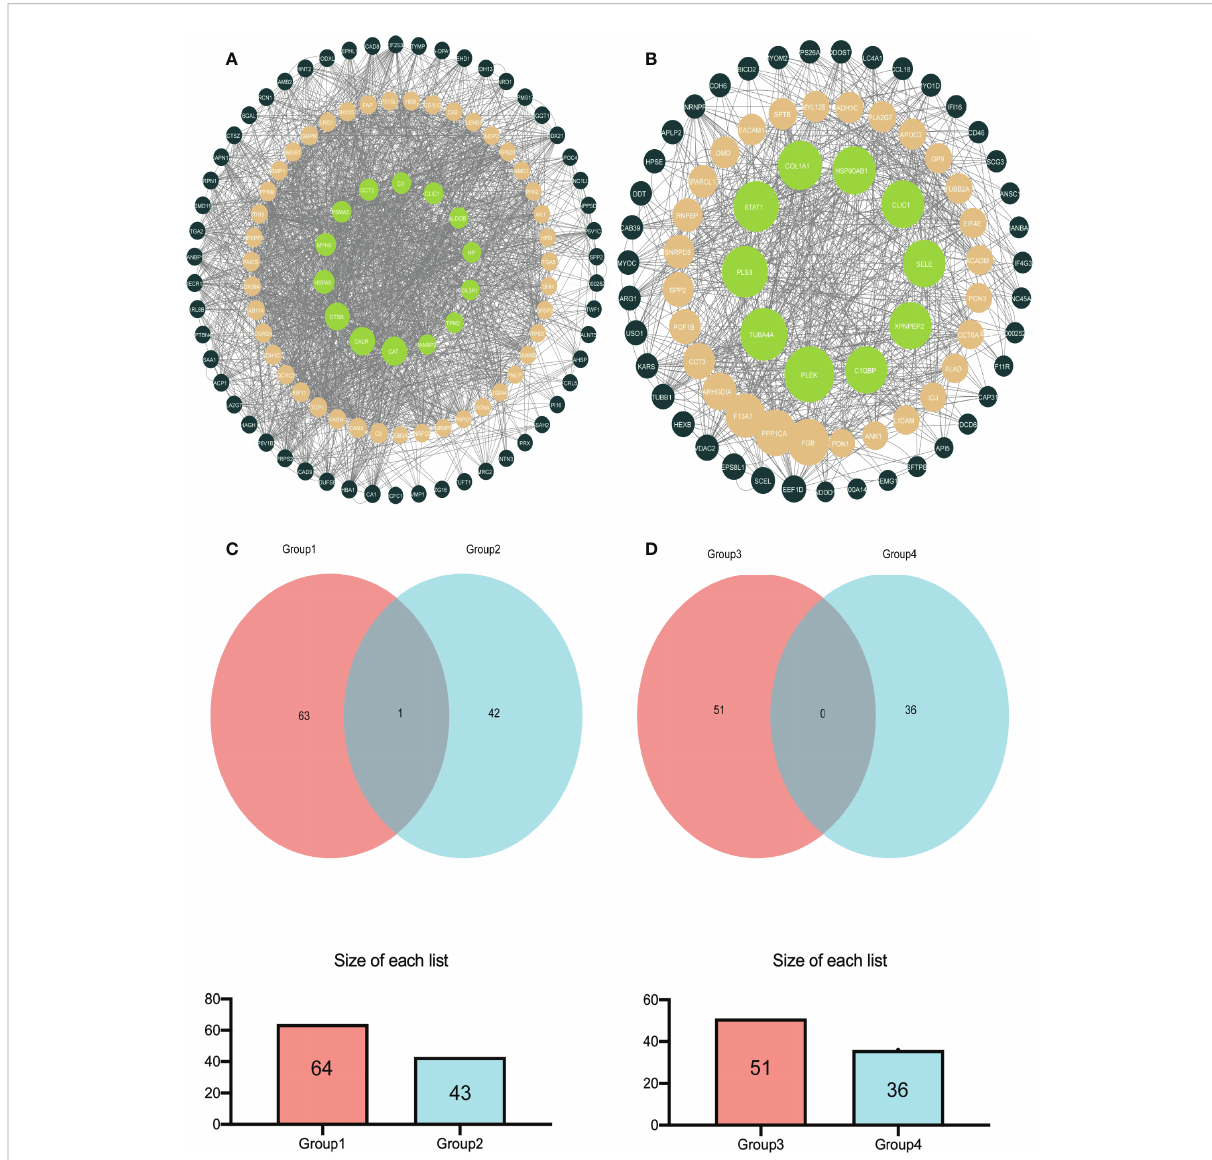
FIGURE 4 The relatively concentrated nets were obtained by PPl analysis and the Venn diagram of the DEPs between group A and group B vs group B and group D (A) Represent the key target network for DEPs in group A and group B (B) Represents the key target network for DEPs in group B and group D, the line represents the protein interaction recorded or predicted by STRING, and each node represents the key proteins recorded by Cytoscape. (C) Represents the common DEPs increased between group A and group B and increased between group B and group D (D) Represents the common decreased